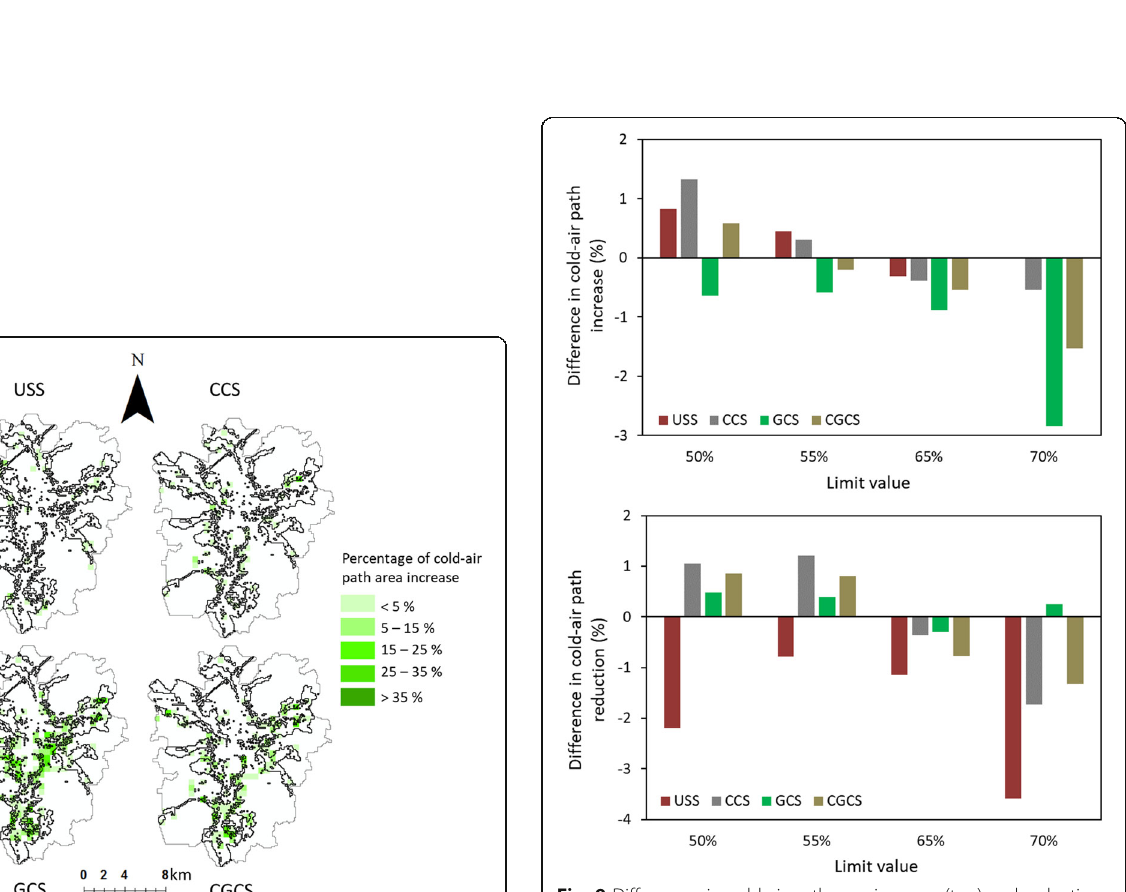
Fig. 9 Differences in cold-air path area increase (top) and reduction (bottom) for the scenarios (USS: Urban Sprawl Scenario, CCS: Com- pact City Scenario, Green City Scenario, CGCS: Compact Green City Scenario) from the used limit value setting of 60% occurrence prob- ability for the tested limit values of 50%, 55%, 65% and